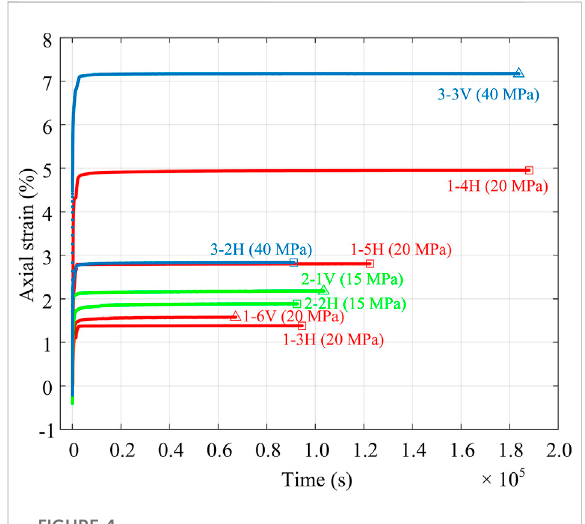
FIGURE 4 Axial strain responses of the samples from three wells under hydrostatic conditions. For each curve, the sample name and the corresponding con fi ning pressure are explicitly indicated. For comparison, each pair of the samples are from the same depth, i.e., 1 – 3 H and 1 – 4 H, 1 – 5 H and 1 – 6 V, 2 – 1 V and 2 – 2 H, 3 – 2 H and 3 – 3 V (see Table 1 for more